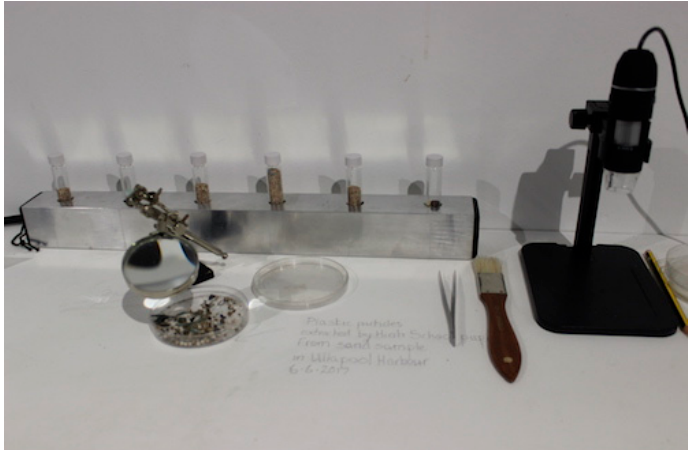
Figure 7. Interactive Lab at Neo Terra exhibition, An Talla Solais, Ullapool. 13 May–18 June 2017. Photograph created by the author.